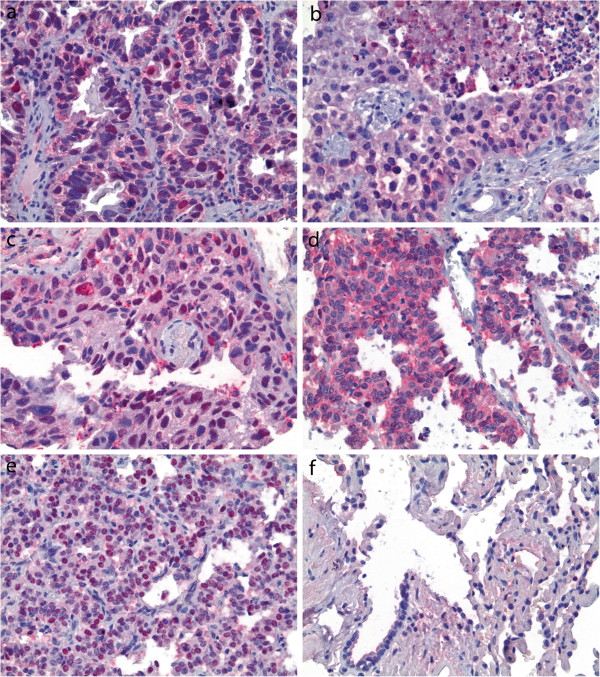
Cytoplasmic (a-e) and nuclear (a, c and e) expression of PRMT5 is seen throughout the entire spectrum of lung tumors; representative examples of adenocarcinoma (a), squamous cell carcinoma (b-c), large cell neuroendocrine carcinoma (d) and typical carcinoid tumor (e); no PRMT5 is observed in normal alveolar parenchyma (f) Panels (b) and (d) illustrate low and high cytoplasmic expression, respectively; panels (a) and (e) illustrate low and high nuclear expression, respectively; immunohistochemistry; original magnification ×400.